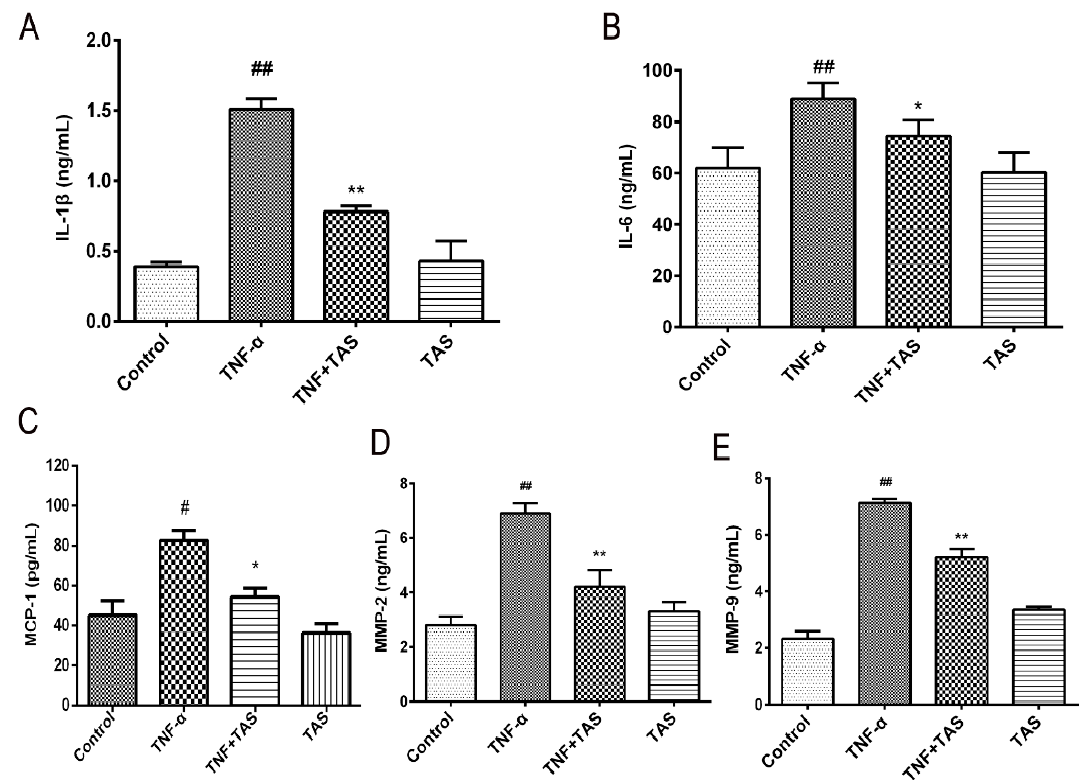
Figure 3. TAS suppressed the TNF- α -triggered inflammatory response in HUVECs. HUVECs were preincubated with TAS (5 µ g/mL) for 2 h, followed by treatment with TNF- α (50 ng/mL) for 24 h. ( A ) IL-1 β levels were measured by ELISA. ( B ) IL-6 levels were measured by ELISA. ( C ) MCP-1 expression after TAS treatment. ( D ) MMP-2 expression after TAS treatment. ( E ) MMP-9 expression after TAS treatment. The data are presented as the mean ± SD of three independent tests. # p < 0.05 and ## p < 0.01, versus the control group; * p < 0.05 and ** p < 0.01 versus the TNF- α -incubation group.